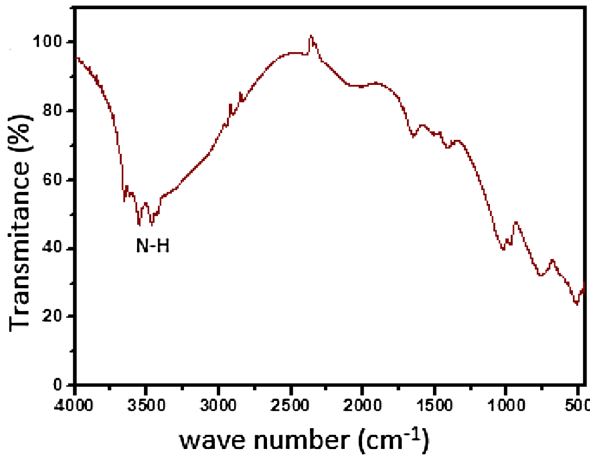
Figure 6. FTIR spectrum of a pseudoboehmite/acyclovir sample.